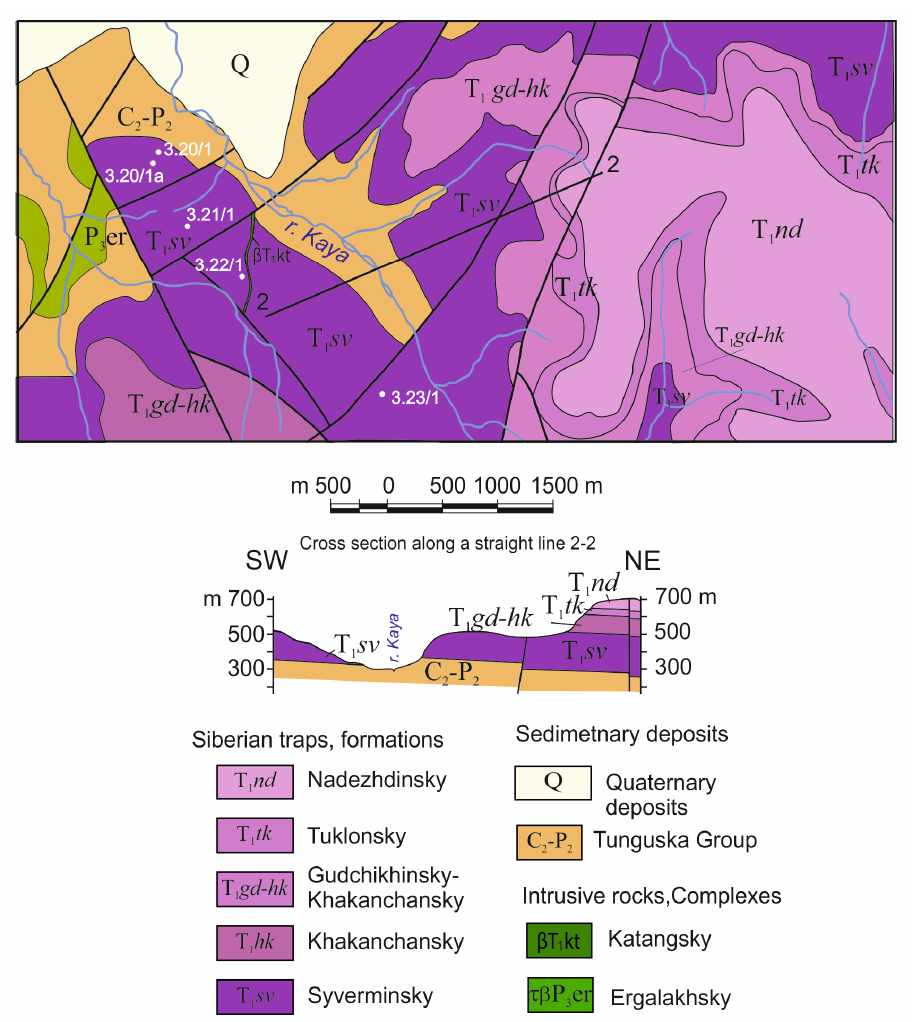
Figure 5. Geological map of the Kaya site (after Ltd. Norilskgeology data with the authors’ corrections).